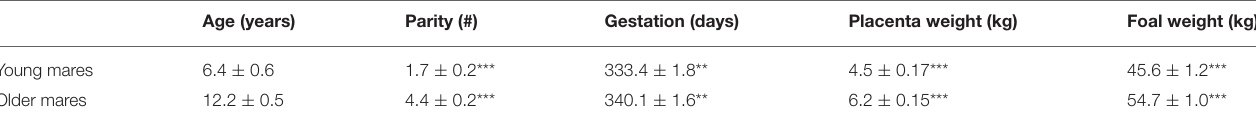
TABLE 2 | Age, parity, gestation length, placenta weight (kg), and foal weight (kg) at 24h post-foaling, in the two groups of mares (mean ±